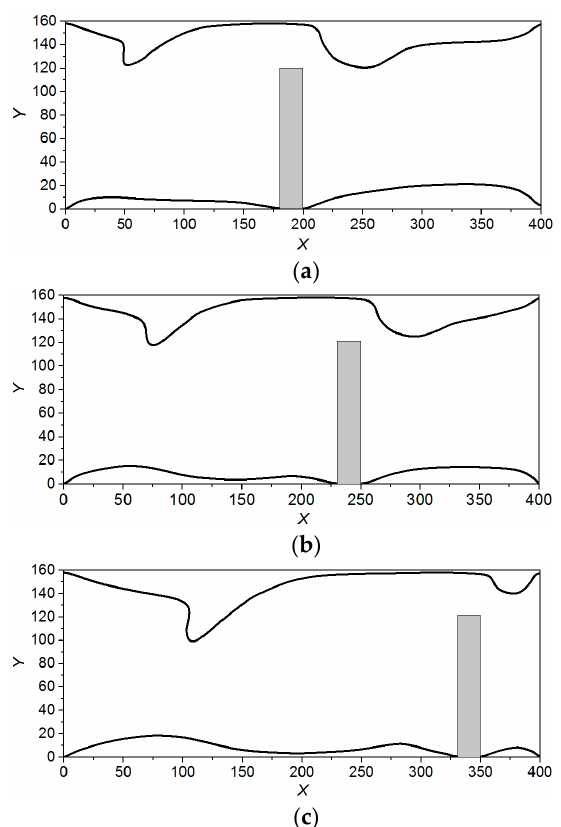
Figure 8. Contour line of the boundary layer in the flow field at different n ( n is the simulation steps). ( a ) n = 900; ( b ) n = 1400; ( c ) n = 2400.